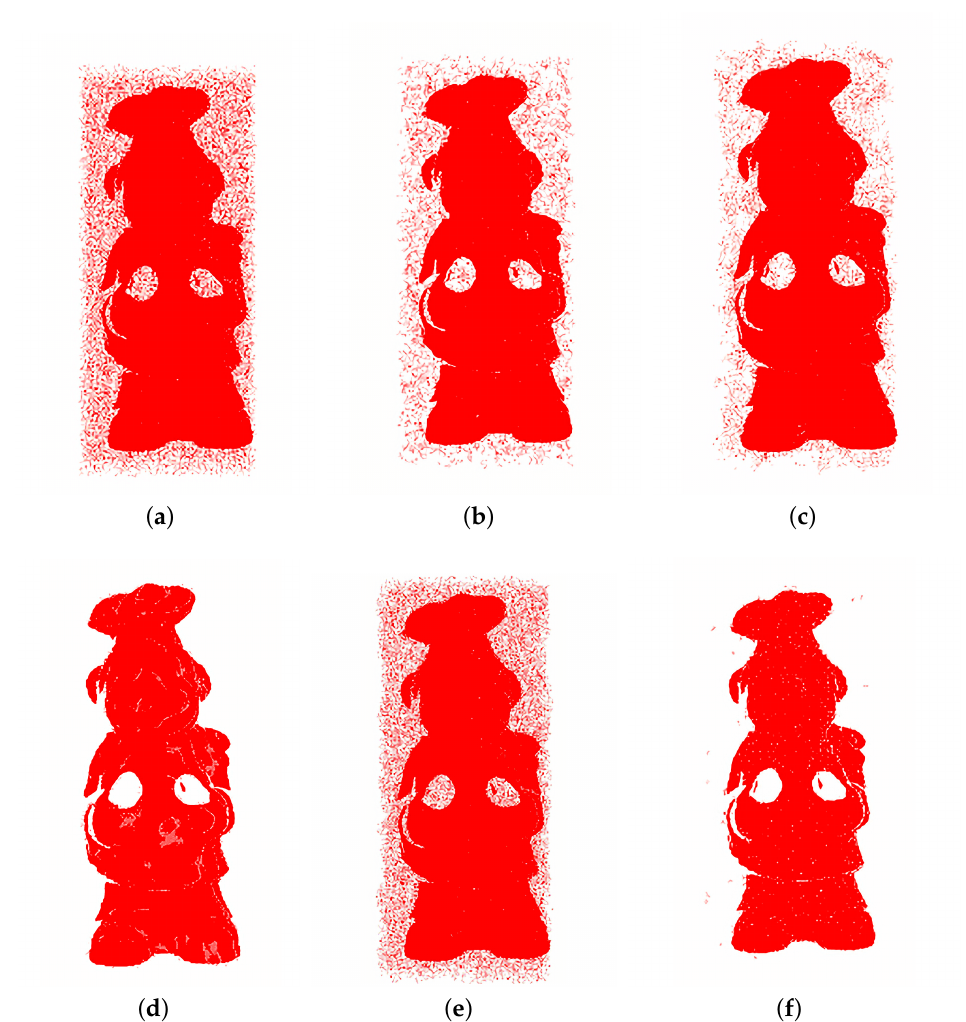
Figure 5. The outlier removal results of different algorithms. ( a ) Chef with 0.5 ratio of random outliers; ( b ) filtering result with Sor; ( c ) KSor; ( d ) KLof; ( e ) DSDT; ( f ) our